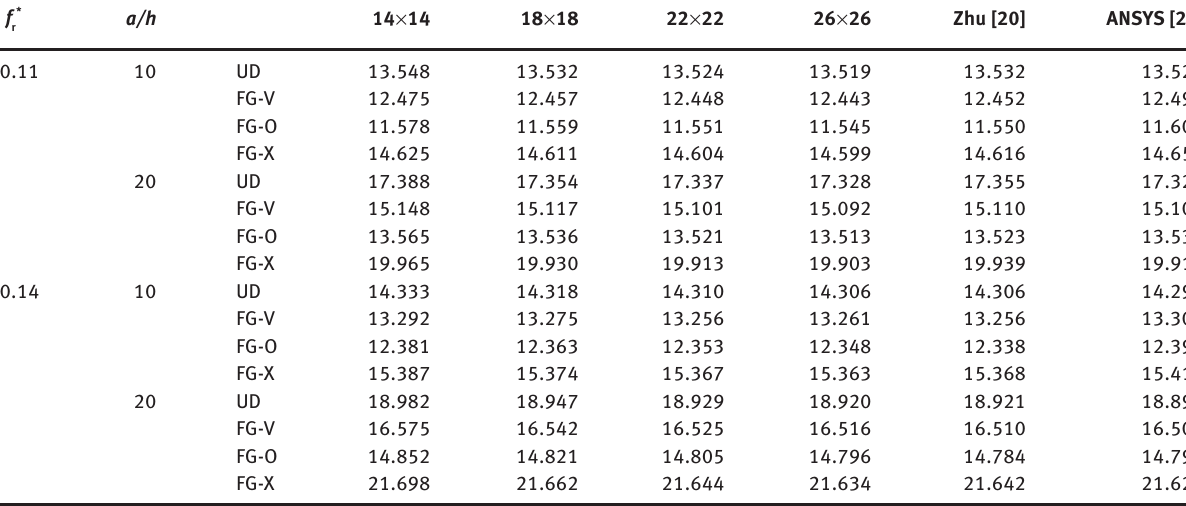
Table 4 Convergence and accuracy of the first dimensionless natural